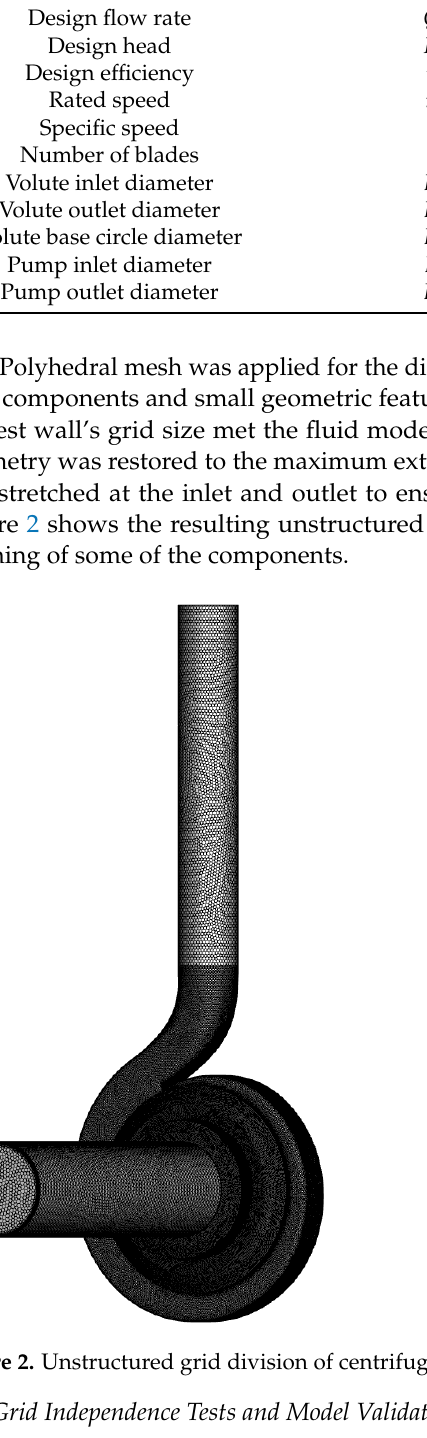
Figure 3. Local mesh division of the impeller water body and volute. 3.2. Grid Independence Tests and Model Validation Five sets of different grids were considered to verify the independence of the grid number. The specific grid data are presented in Table 2. For accuracy, the number of boundary layers at the inlet and outlet was set to 7, with the finest grid size; the growth rate from the boundary layer was set at 1.2; and the transient ratio was set at 0.272. The average skewness of the generated polyhedral mesh was 0.015, and the maximum skew- ness was kept at less than 0.6. The efficiency of the centrifugal pump was used as a criterion for the mesh independ- ent studies. It was accepted that when the error of efficiency (through comparison with experimental data [26]) was less than 1%, the grid met the accuracy requirements. The computational time and resources required for the numerical calculation were considered during the studies. As seen in Figure 4, the calculation results tended to smooth out and were extremely close to the experimental data, with an increase in the number of meshes.